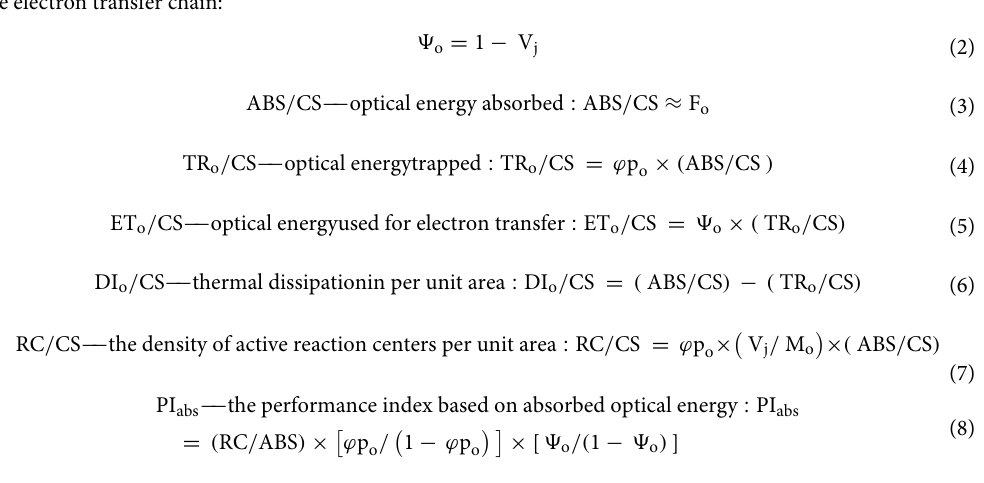
at 200 μmol·m −2 ·s −1 (R:B = 9:1), 24 °C, 400 μmol·mol −1 and 1.1 kPa. The O-J-I-P fluorescence induction curve